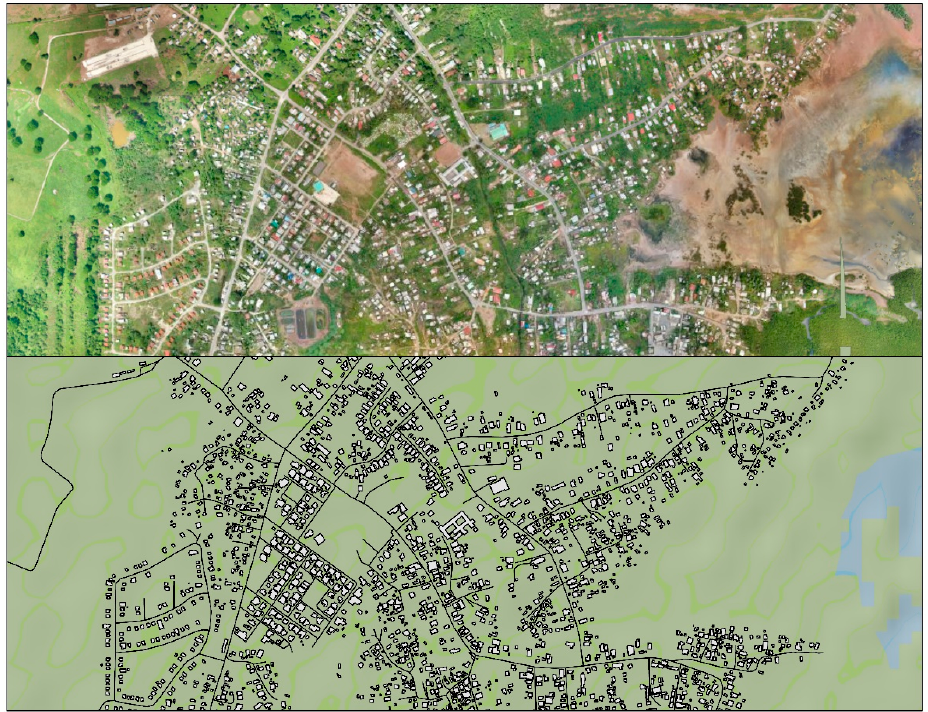
Figure 6. UAV-derived orthophoto mosaic of Old Harbour Bay, Jamaica at 3.8 cm resolution ( top ). Corresponding building footprints and roads digitized from the orthophoto mosaic for use in the socioeconomic and flood analysis ( bottom